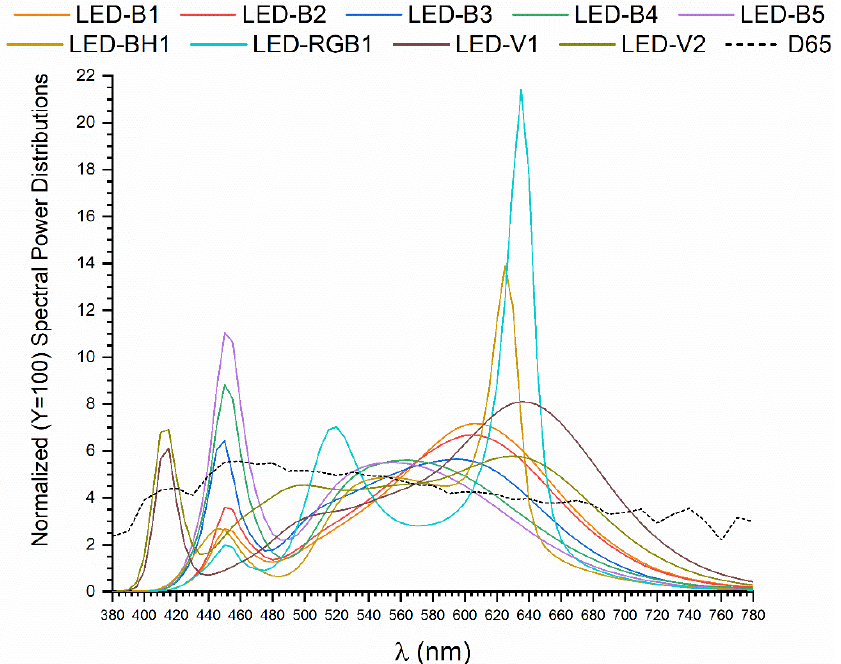
Figure 3. Normalized (Y = 100) spectral power distributions of the 9 white CIE LED illuminants and CIE D65 illuminant [2].